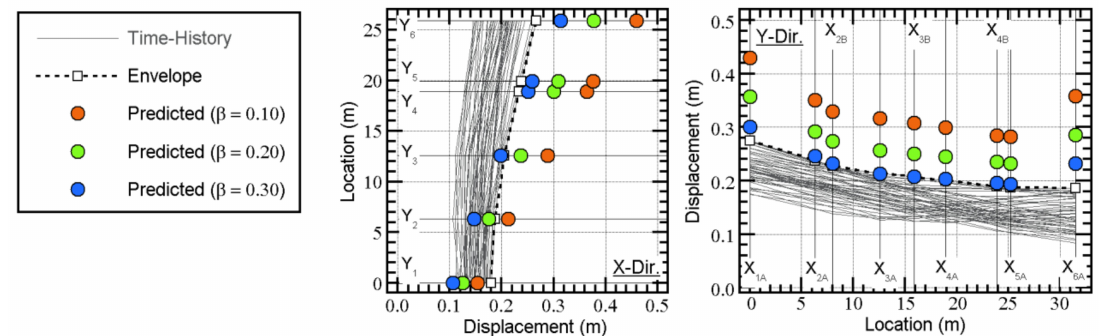
Figure 22. Comparison of the horizontal distributions of the peak displacement at level 0 (model: Model-Tf34, ground motion: Art-1 series).